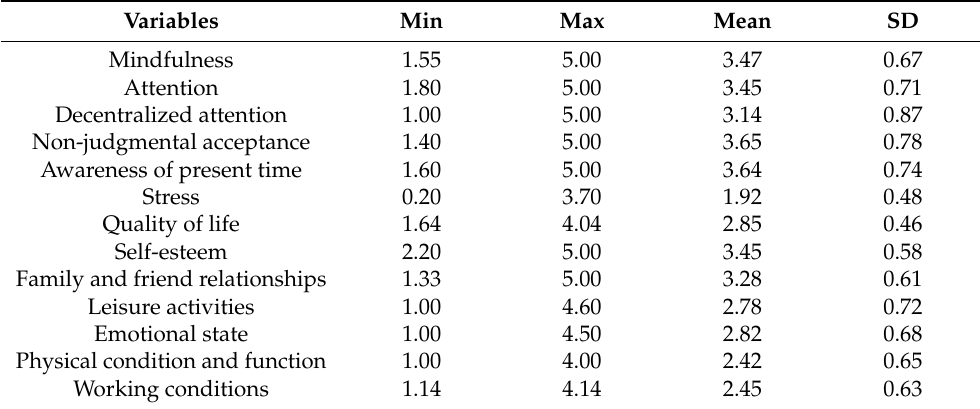
Table 2. Level of mindfulness, stress, and quality of life ( N = 206).